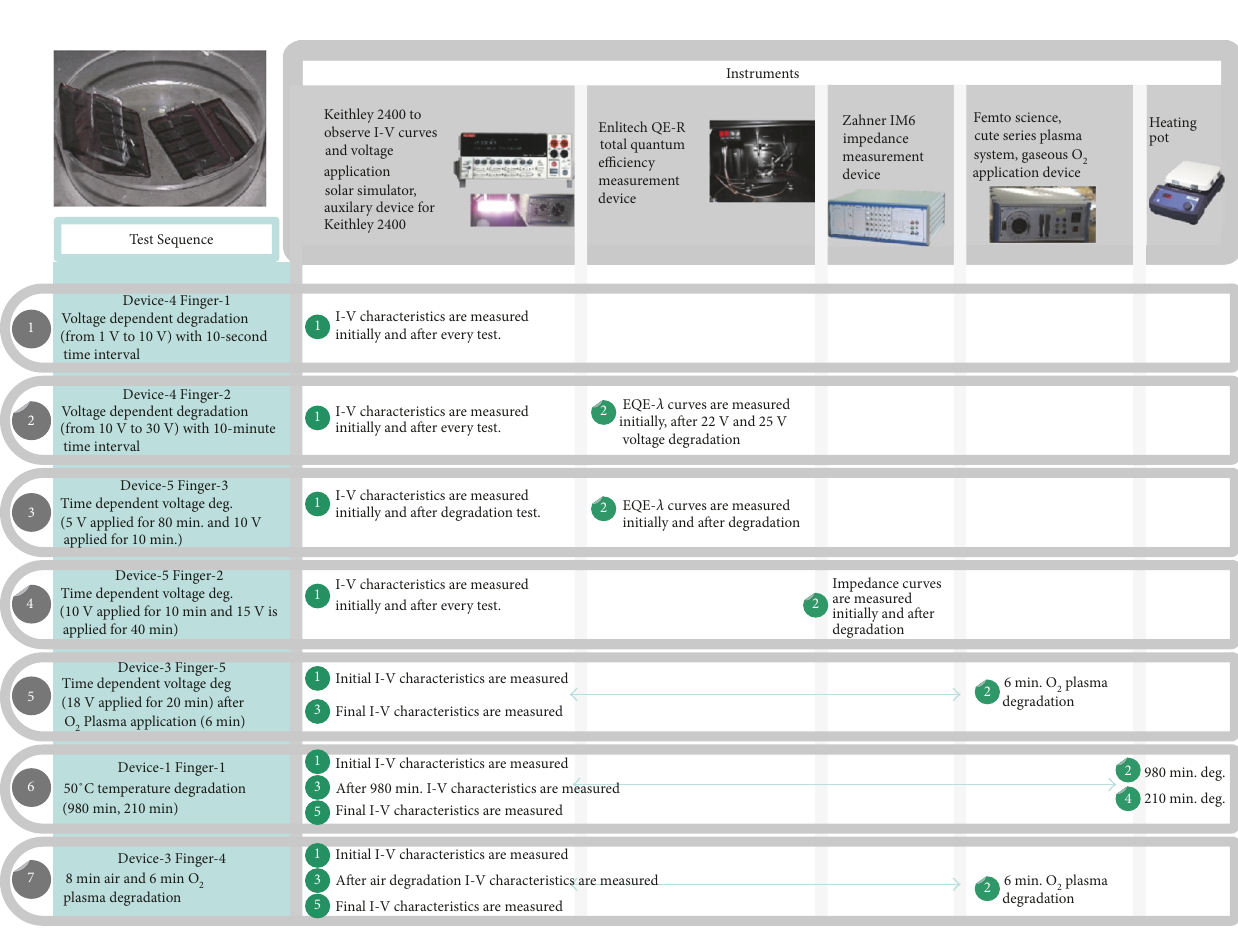
Figure 5: Testing procedure.